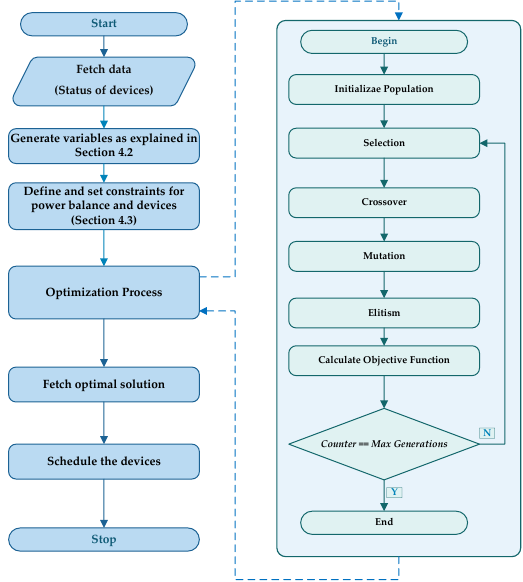
Figure 4. Flowchart of the proposed